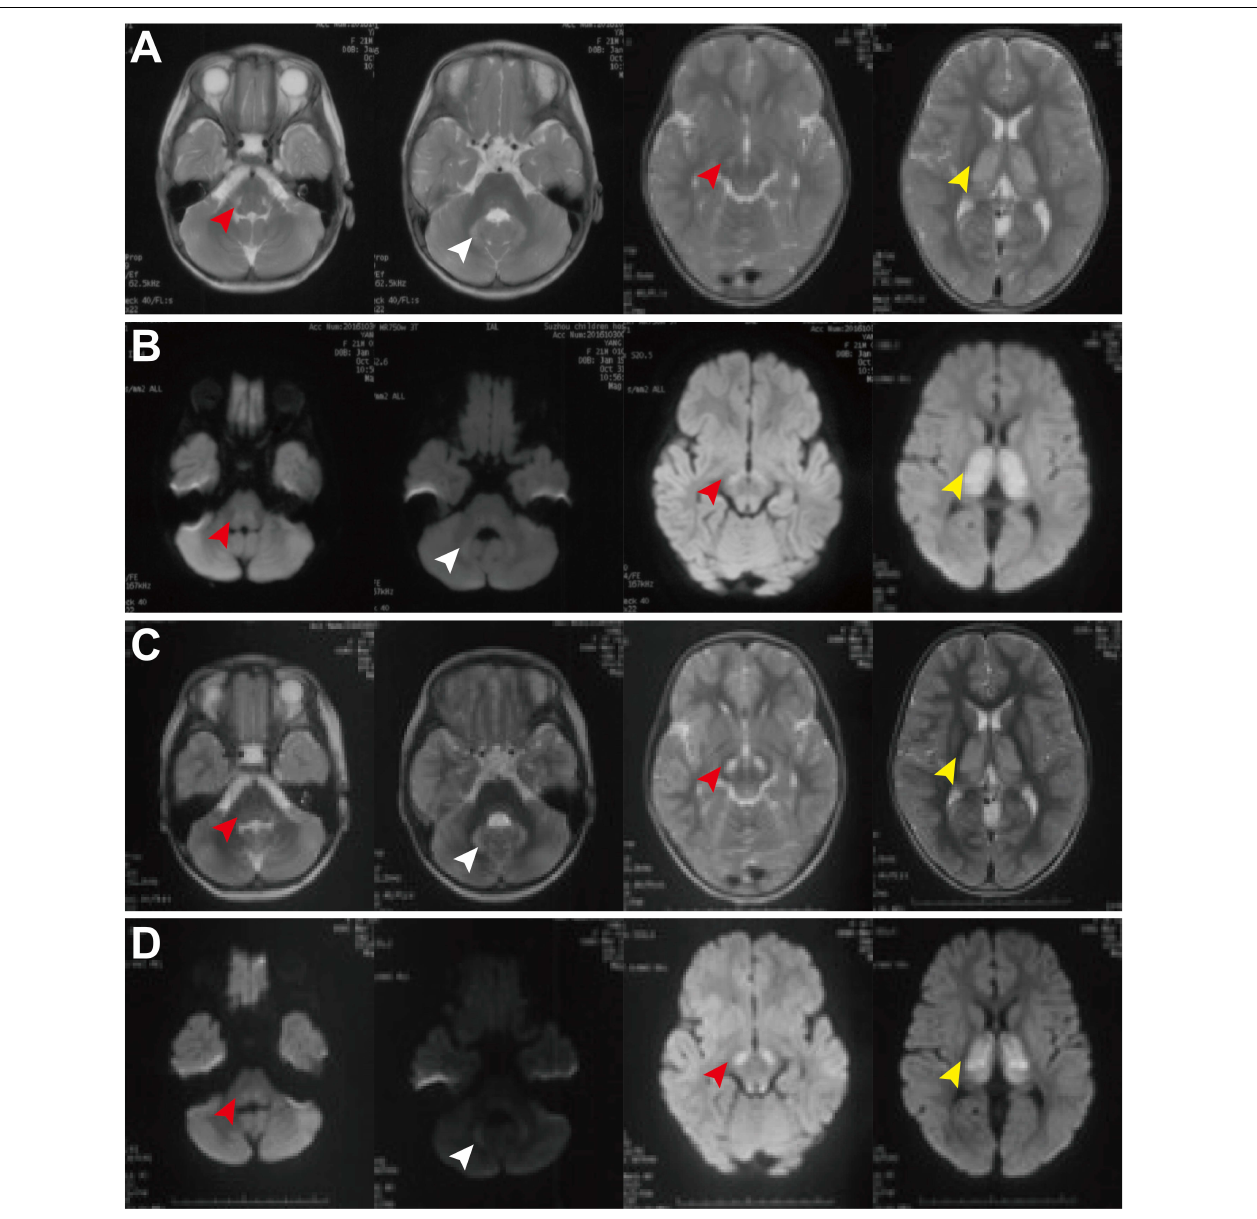
FIGURE 1 | Brain MRI of patient 3 at the ages of 1 year and 9 months old (A,B) and 3 years and 8 month old (C,D) . MRI demonstrated bilateral lesions in the brain stem (red arrowheads), thalamus (white arrowheads), and dentate body of cerebellum (yellow arrowheads), with diffusion limitation in diffusion weighted image. There is no significant improvement during the follow-up